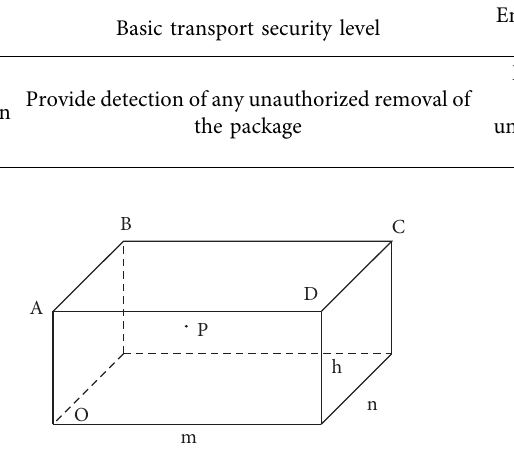
Figure 3: A simple scheme of the different elements of the de- tection model. Figure